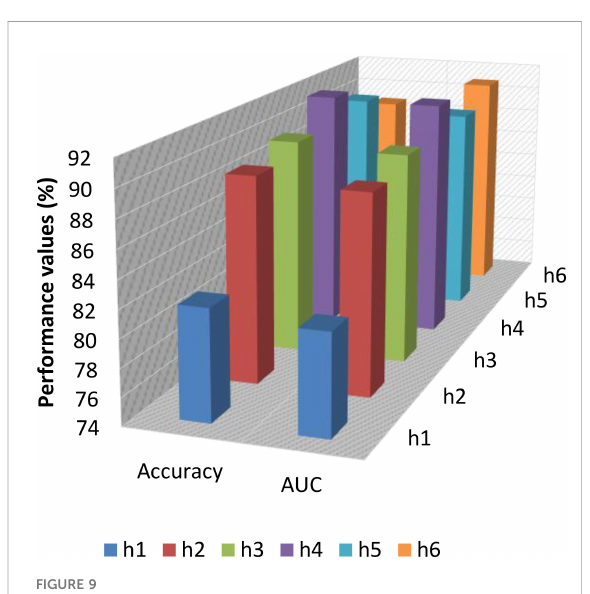
FIGURE 9 AUC values based on the number of hidden layers.